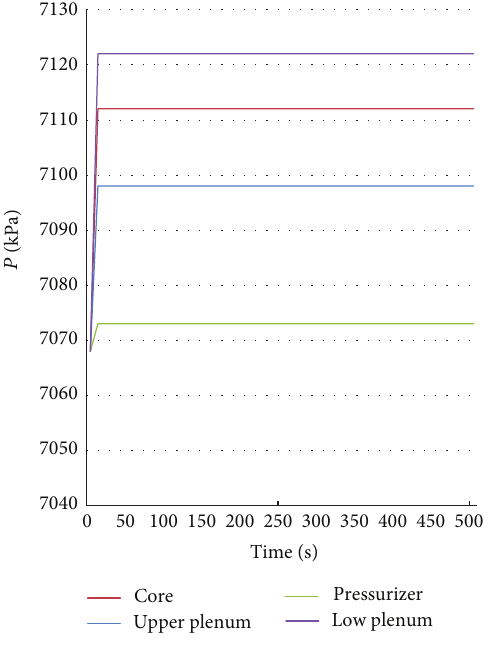
Figure 7: Pressure of reactor core, upper plenum, low plenum, steam, and pressurizer in steady